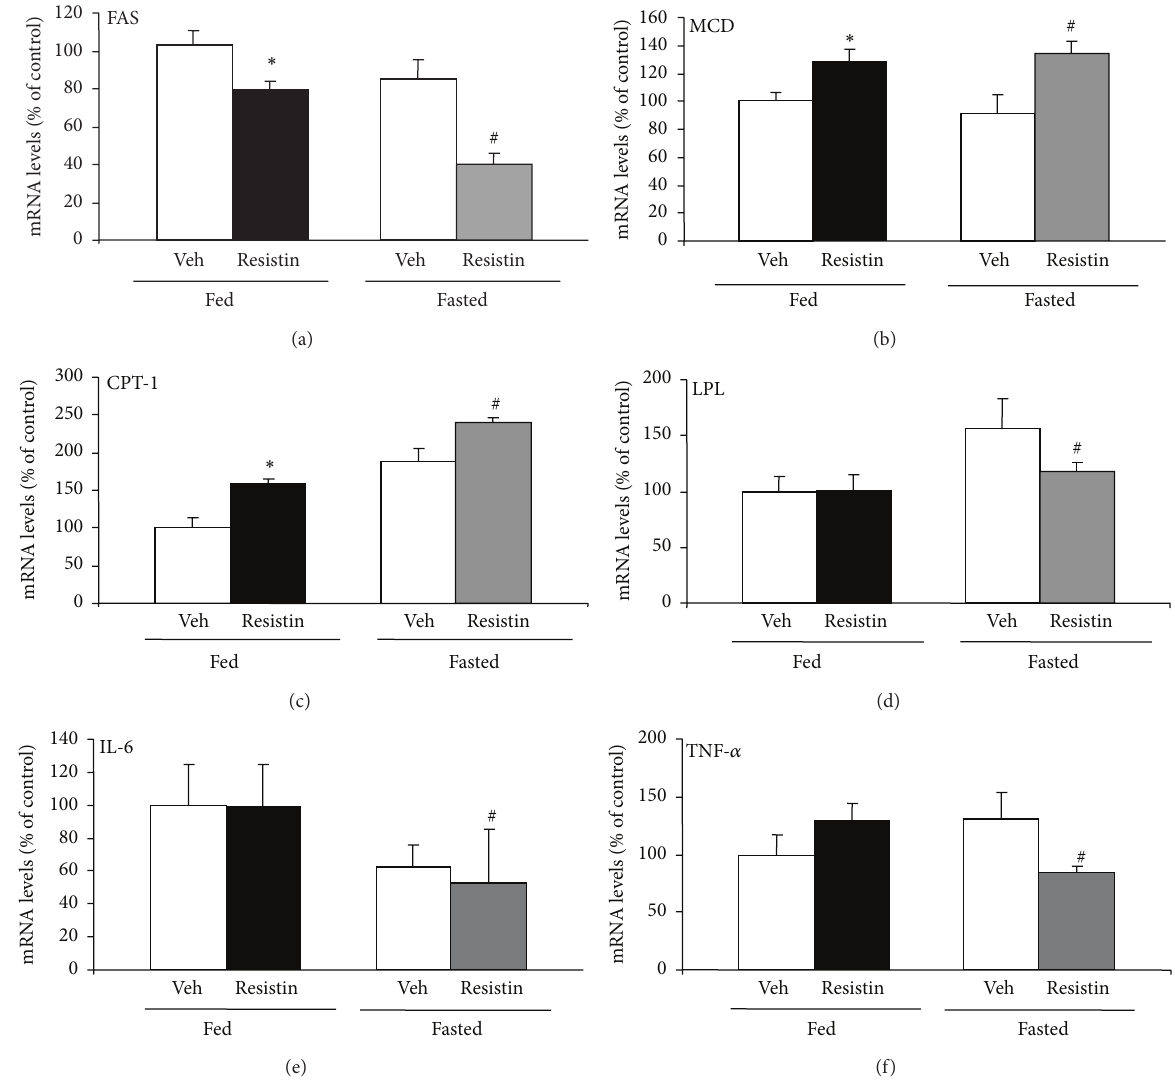
Figure 2: Effect of central chronic administration of resistin on pituitary lipid metabolism enzymes and proinflammatory cytokines. Mean + SEM mRNA levels of FAS, MCD, CPT-1, LPL, IL-6, and TNF-alpha in the pituitary gland of fed and fasted rats following administration (I.C.V.) of vehicle (Veh) or resistin (10ug/day/over six days. 𝑁 = 6 – 8 rats per group assay; ∗ 𝑃 < 0, 05 versus fed vehicle; # 𝑃 < 0.05 versus fasted